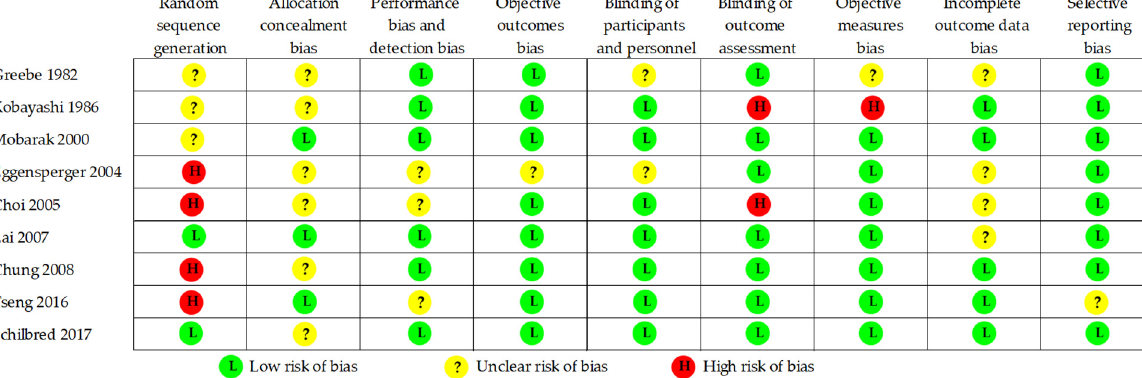
Figure 2. Risk of bias summary.